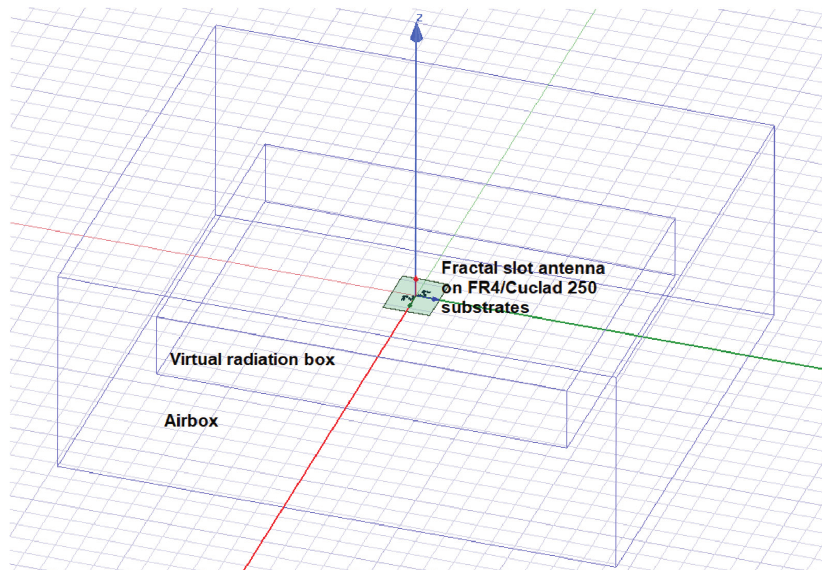
Figure 3: Simulation environment for the slot fractal antenna where the geometry can be observed including the subdomains